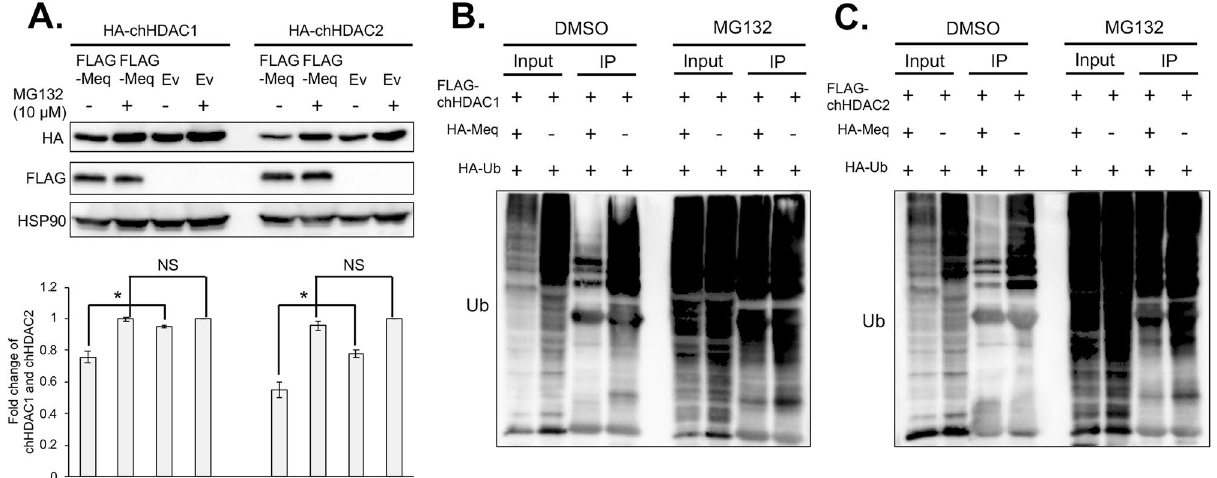
Figure 6. MDV Meq mediates the partial degradation of chHDAC1 and 2 via the proteasome dependent pathway. ( A ) pcDNA-HA-chHDAC1 or pcDNA-HA-chHDAC2 were co-transfected with pcDNA-FLAG- Meq or pcDNA empty vector (Ev) into 293T cells and 24 h later, cells were treated overnight with or without MG132 (10 μM). Western blot (WB) analysis was performed with whole cell lysates using the indicated antibodies. Representative WB images were shown (upper). Protein levels of HA-chHDAC1 or HA-chHDAC2 were quantified with Image J, normalized to HSP90, and presented as fold change compared to MG132 treated pcDNA-HA-chHDAC1 or pcDNA-HA-chHDAC2 and pcDNA Ev cotransfected cells (bottom). The statistical differences were analyzed by Student t test. * p < 0.05, NS not significant. pcDNA-FLAG-chHDAC1 ( B ) or pcDNA-FLAG-chHDAC2 ( C ) were co-transfected with pcDNA-HA-Meq or pcDNA Ev and pcDNA- HA-Ub into 293T cells. Twenty-four hours post transfection, cells were treated with MG132 (10 μM) or DMSO overnight. Immunoprecipitations were performed with mouse anti-FLAG agarose beads, followed by WB with ubiquitin